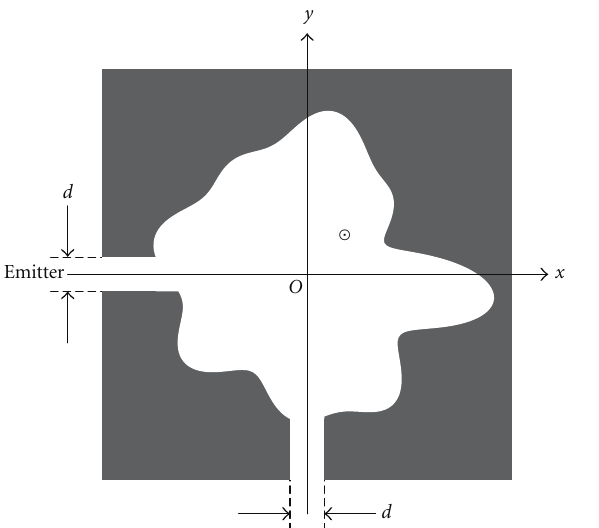
Figure 4: Angular distributions P ( θ ) of the electrons transmitted to the collector for the injection of each three propagating modes. Kd = 10, r max = 4, a max = 1 . 5.